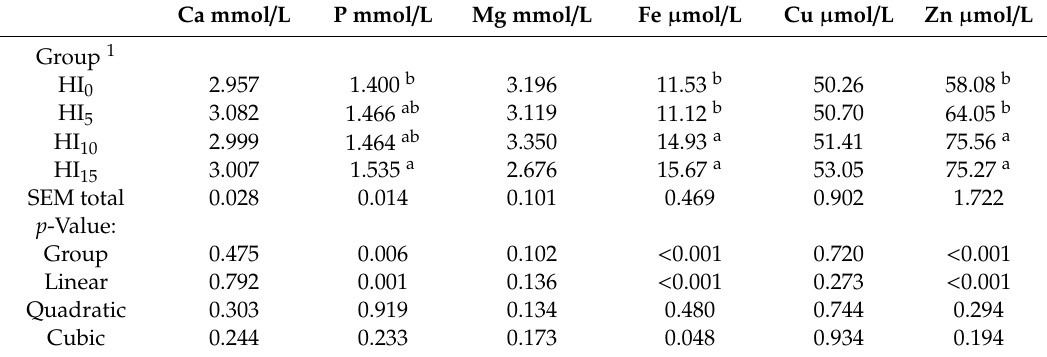
Table 5. Minerals content in the blood of